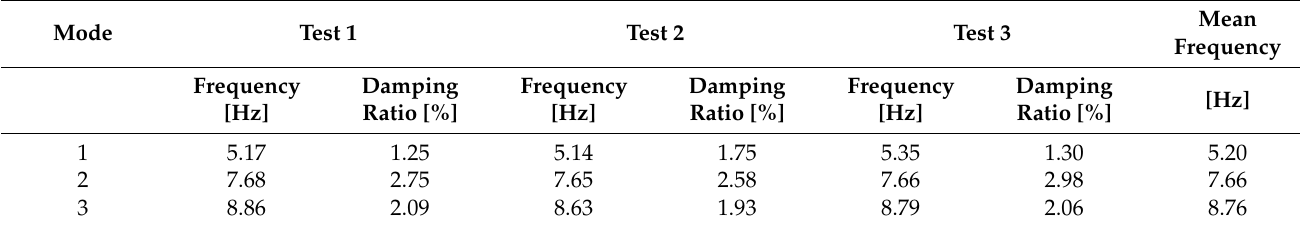
Table 2. Identified frequency